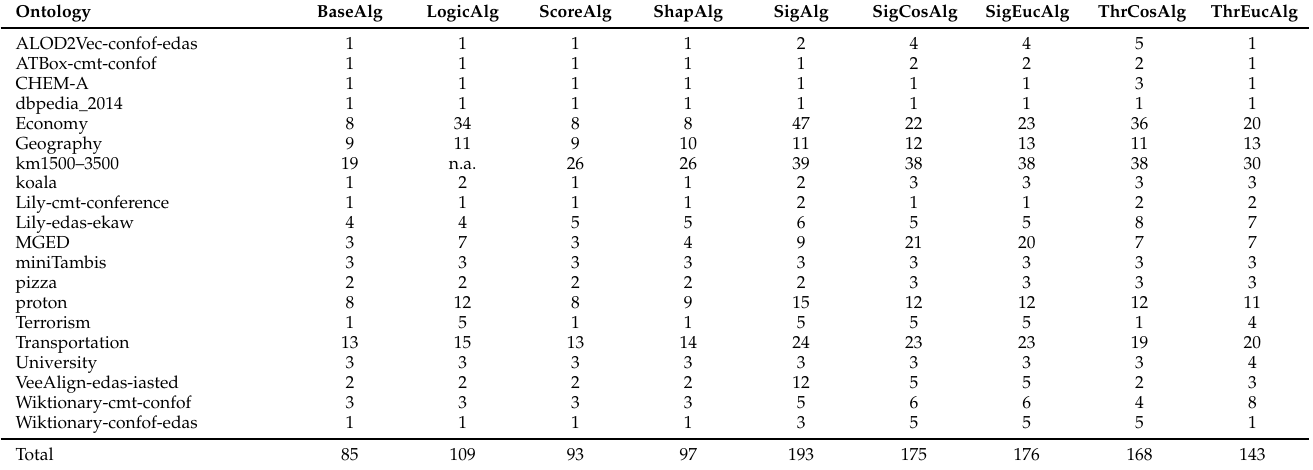
Table 4. Repair results about the number of the axioms removed by each repair algorithm (using the model m1 and the threshold 0.5), where “n.a.” indicates “not available”.